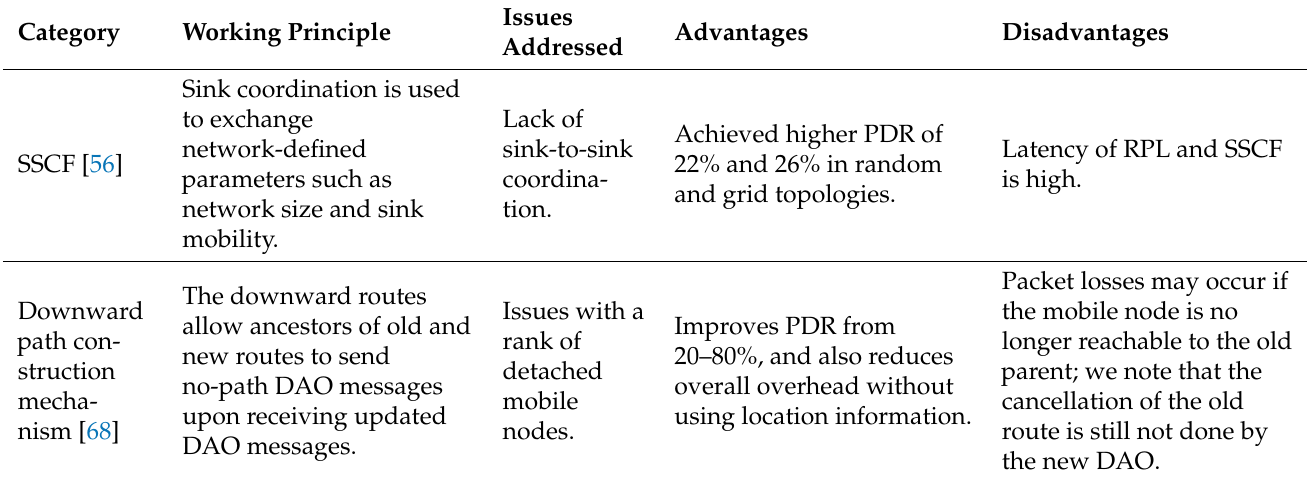
Table 5. Summary of Miscellaneous